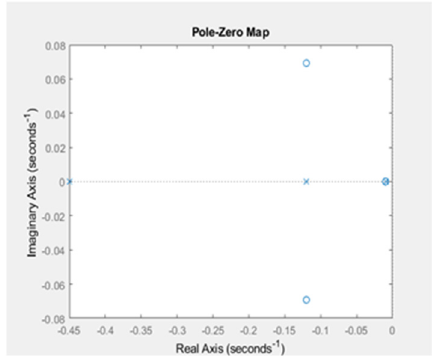
Figure 22. Plot of poles and zeros of n = 4, state variables.